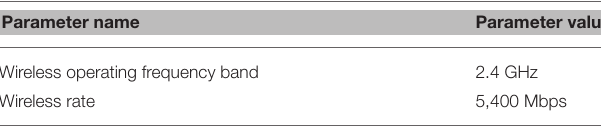
TABLE 3 | Technical parameters of the selected wireless